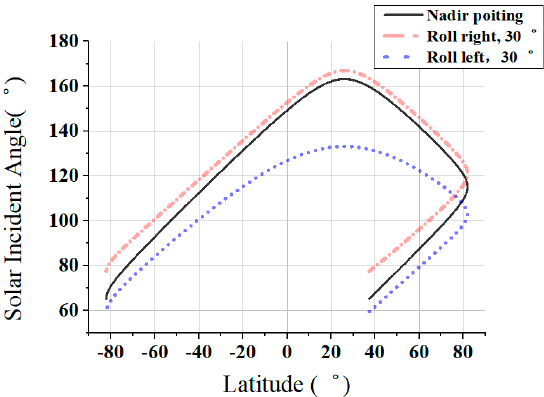
Figure 6. Angular change between solar vector and camera axis in one orbit cycle.